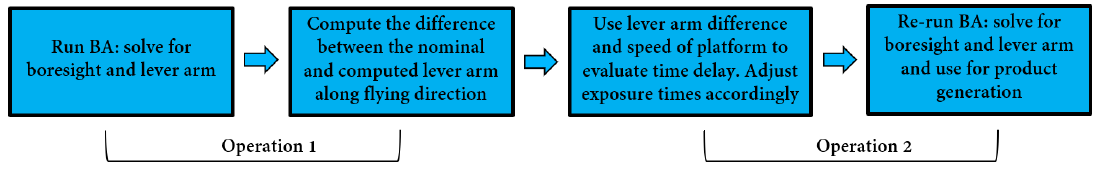
Figure 7. Processing workflow of the indirect approach process for time delay